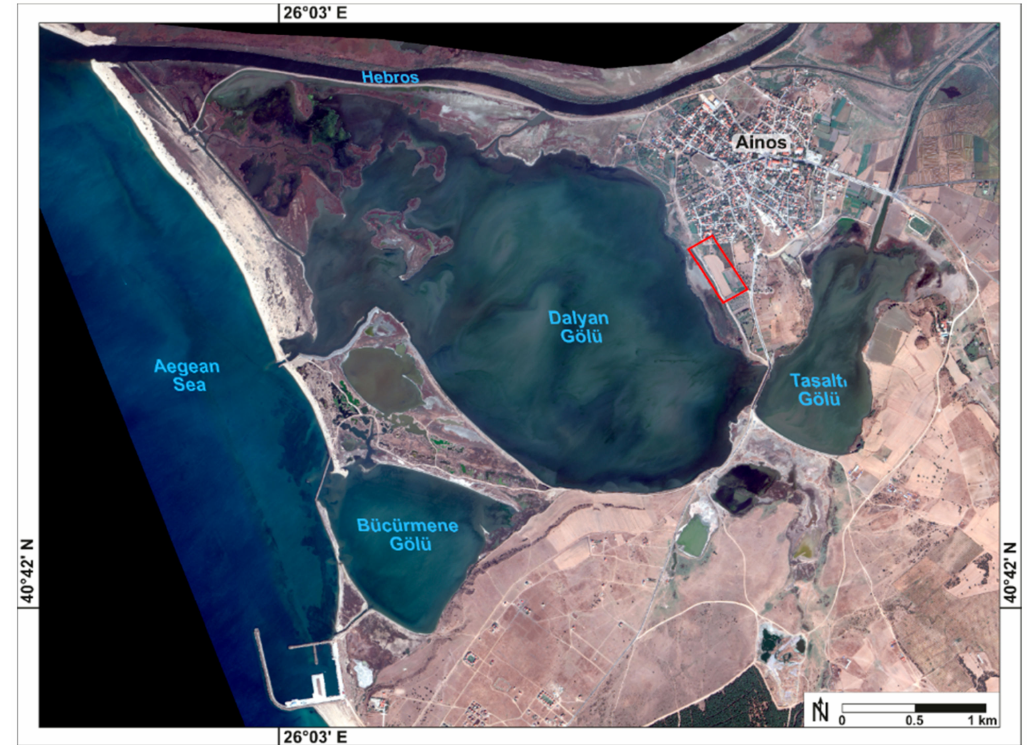
Figure 2. Ainos and its environs. The red rectangle marks the area of the investigated city wall (based on Worldview2; acquired 04 October 2012; composition of bands 1, 3,